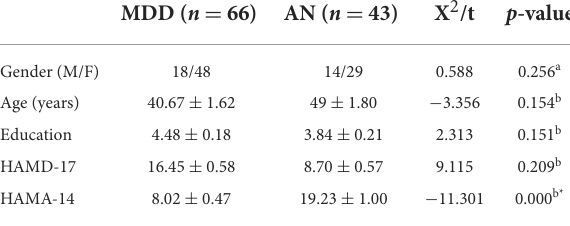
TABLE 1 Demographic characteristics and scale scores of